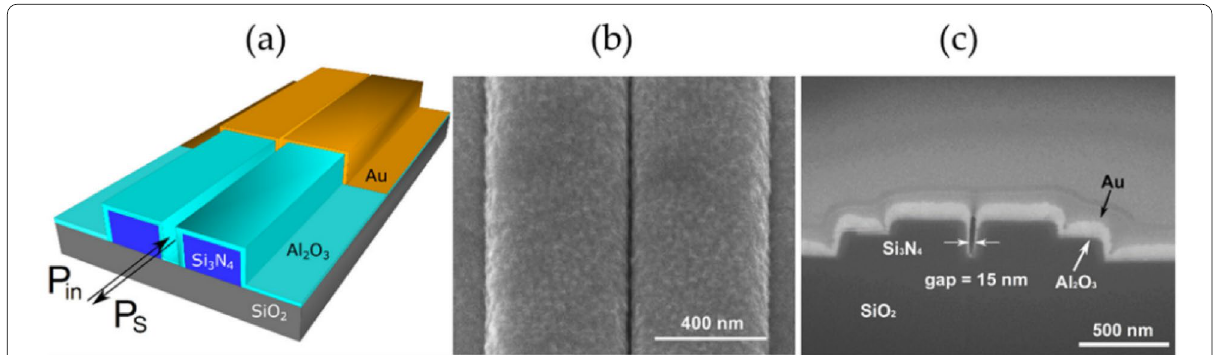
Fig. 15 Nanoplasmonic slot waveguide. a Schematic showing that the input and Stokes powers are guided by the waveguide. b Scanning electron microscope image of the gold-covered slot in top view. c Cross-section of a nanoplasmonic slot waveguide with a gap. Reprinted with permission from Ref.